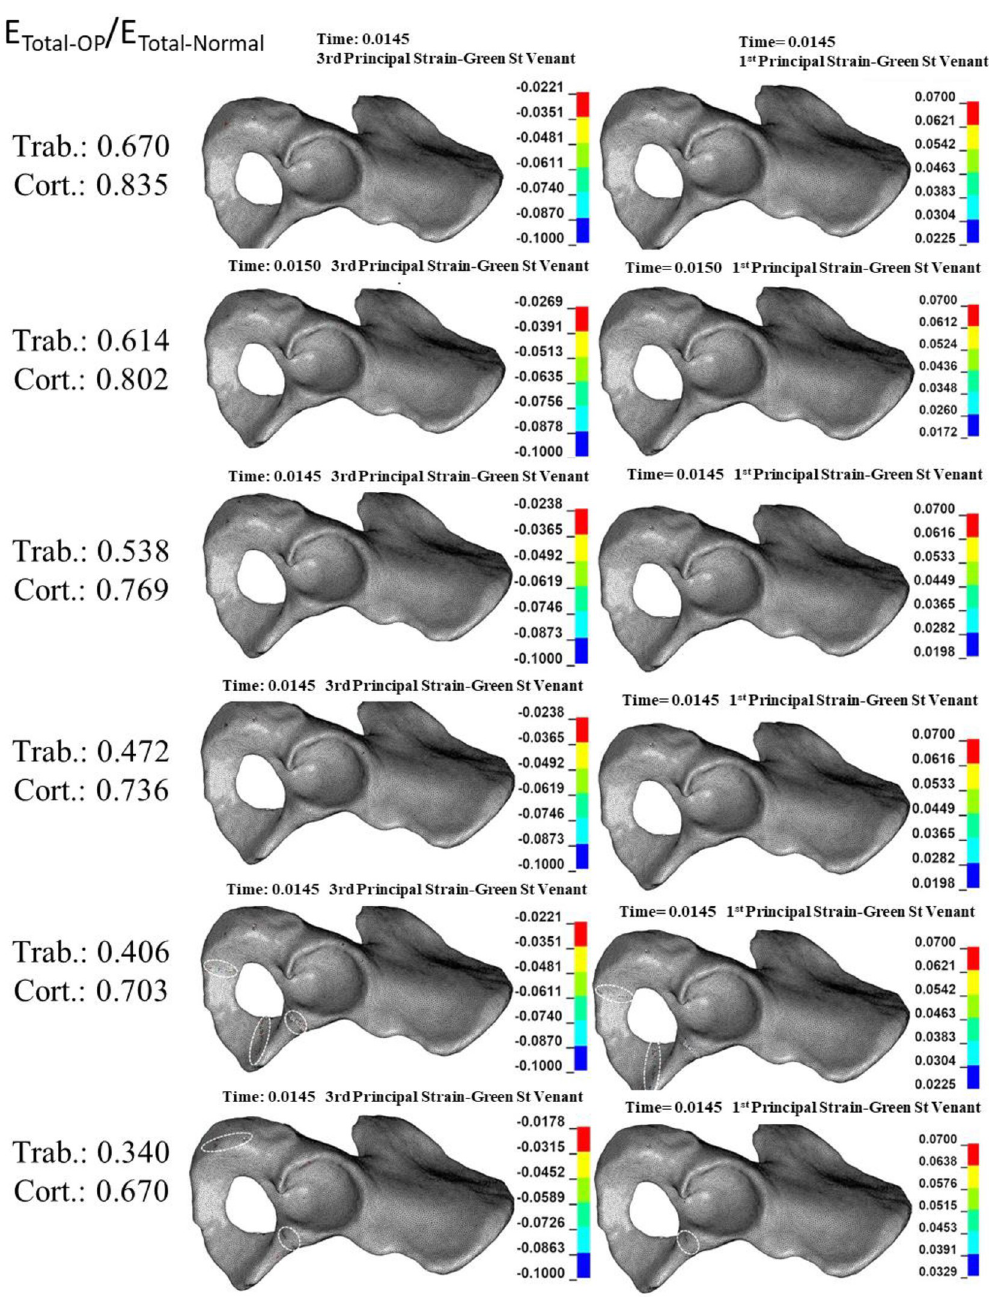
Fig 7. Effect of reduction in total (Trab. + Cort.) elastic modulus (E Total ) on the compressive (left column) and tensile (right column) cortical bone failure. Dashed circles: anatomical landmarks with a high risk of bone